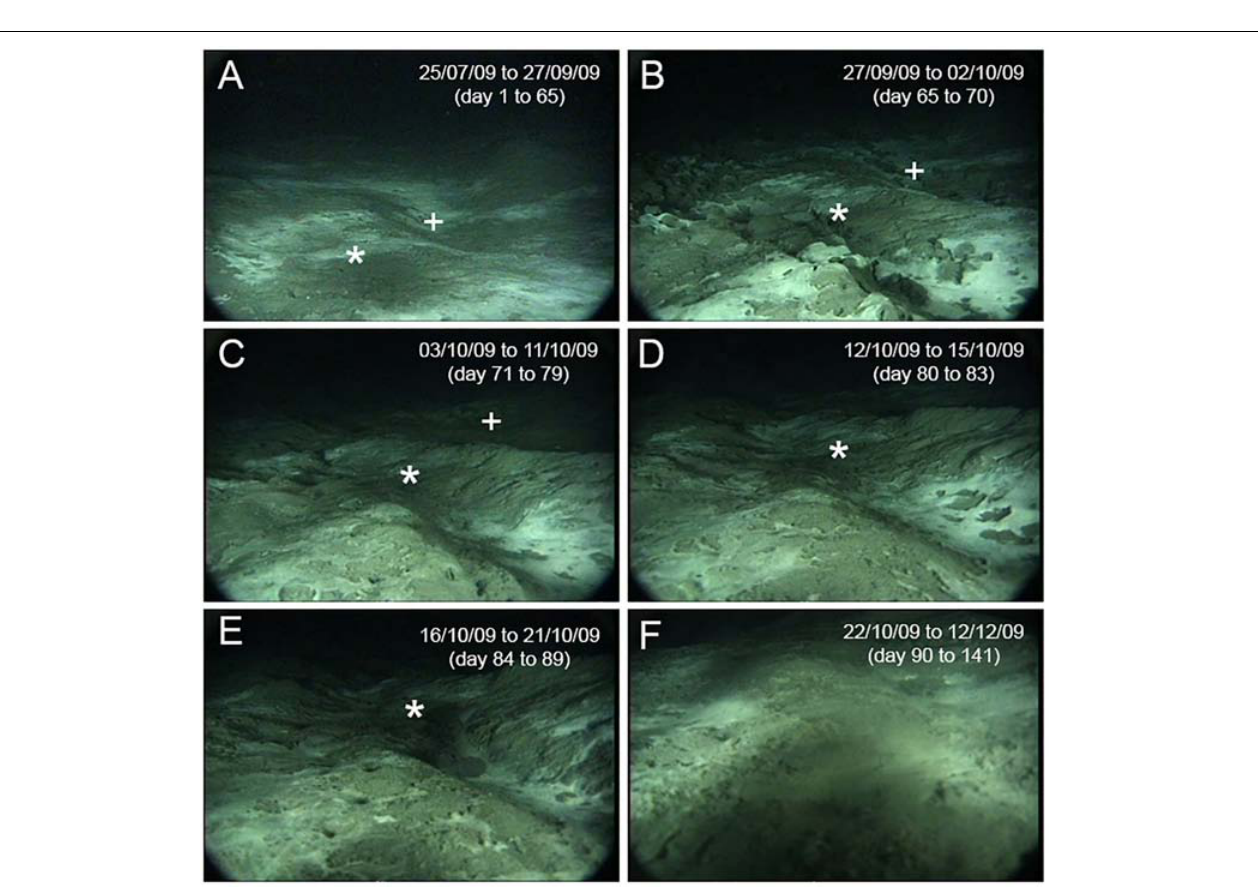
FIGURE 1 | Study site overview. (A) Map showing the LOOME observatory frame (pressure sensor, current meter and thermistor 23) and autonomous imaging module (AIM) locations on the Håkon Mosby mud volcano. (B) Photo of the AIM on the seafloor just after its deployment in 2009.